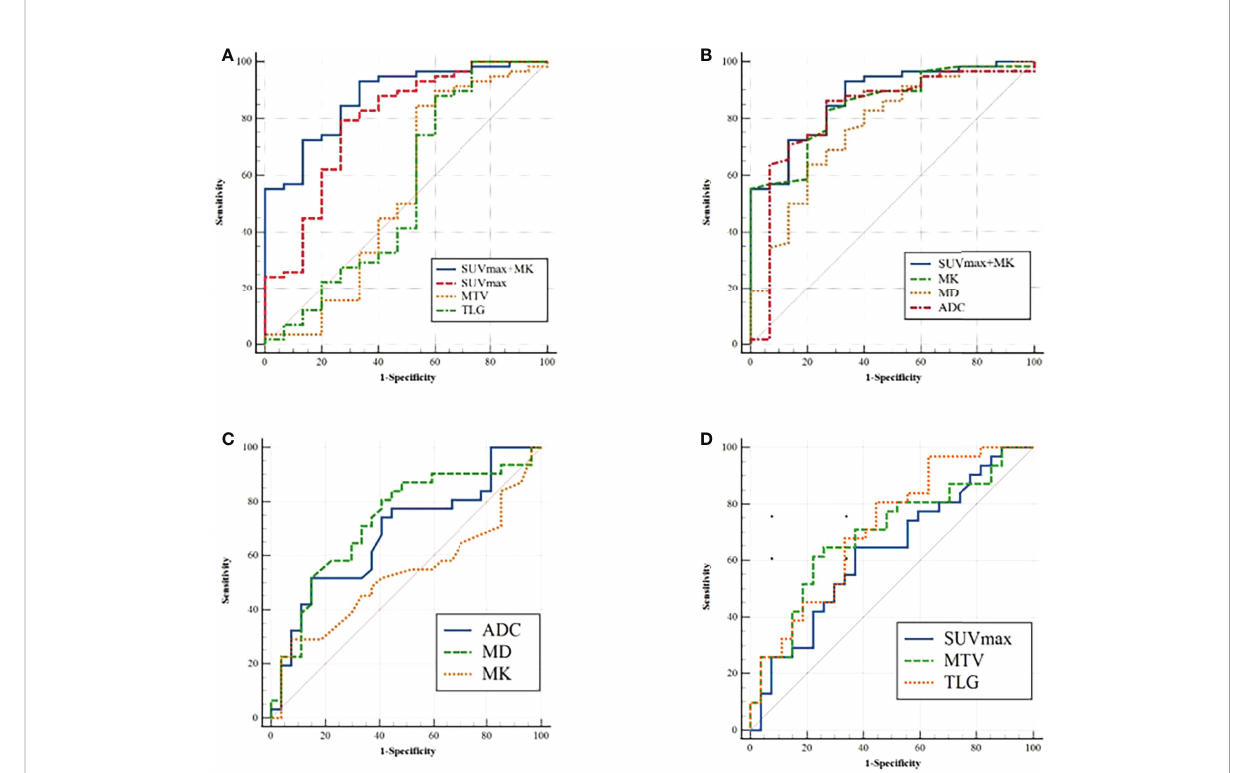
FIGURE 4 (A, B) ROC analysis for differentiation of malignant and benign groups; (C, D) ROC analysis for differentiation of high-grade and non-high- grade